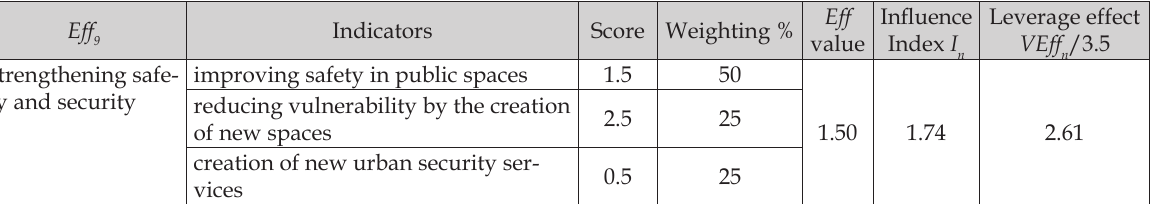
Table 4. Evaluation of Eff (an